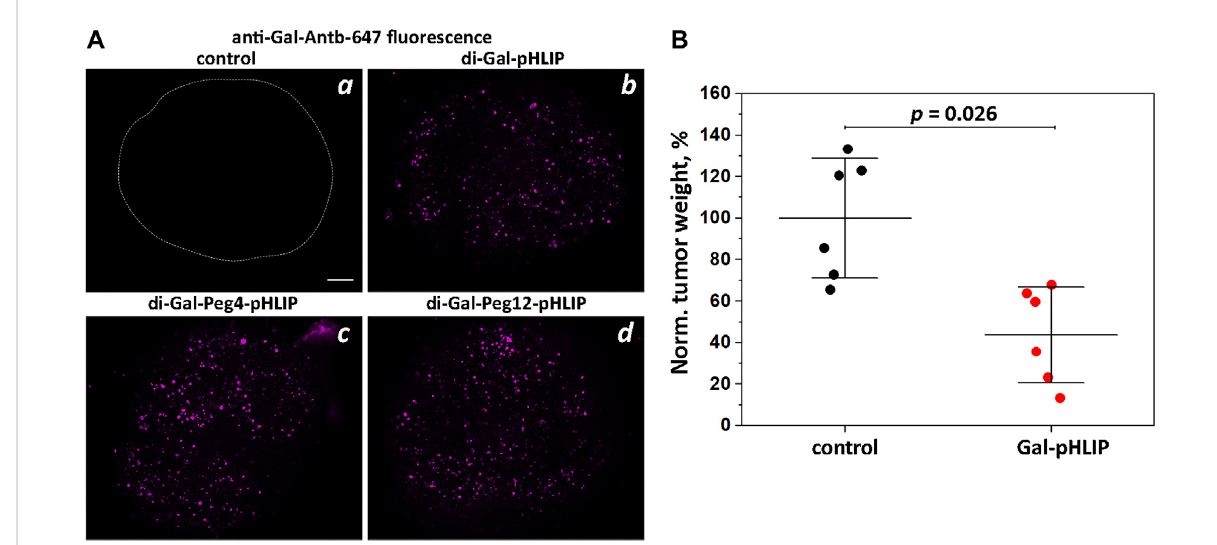
FIGURE 2 Gal-pHLIP in tumor spheroids and mice. Antibody binding and therapeutic performance of Gal-pHLIP agents investigated in tumor spheroids (A) andin mice (B) . (A) HeLatumor spheroids weretreated with medium (a), di-Gal-pHLIP (the contourof thetumor spheroid isoutlined) (b), di-Gal- Peg4-pHLIP (c) and di-Gal-Peg12-pHLIP (d), followed by washing and incubation with anti-Gal-Antb-Al647. Finally, tumor spheroids were washed and imaged using a confocal microscope with a ×10 objective. A 100 μ m scale bar is shown. Representative fl uorescence images are shown in (a – d). (B) Normalized weights of murine melanoma B16F10 tumors collected from A3galt2 knockout mice immunized with HSA-Gal/CFA and HSA- Gal/IFA and treated with Gal-pHLIP are shown. The mean weight of tumors in the control group was taken as 100%. The distributions of tumor weights in the control (non-treated) group and Gal-pHLIP (treated) group are statistically different as established by the Kolmogorov-Smirnov two- tailed non-parametric